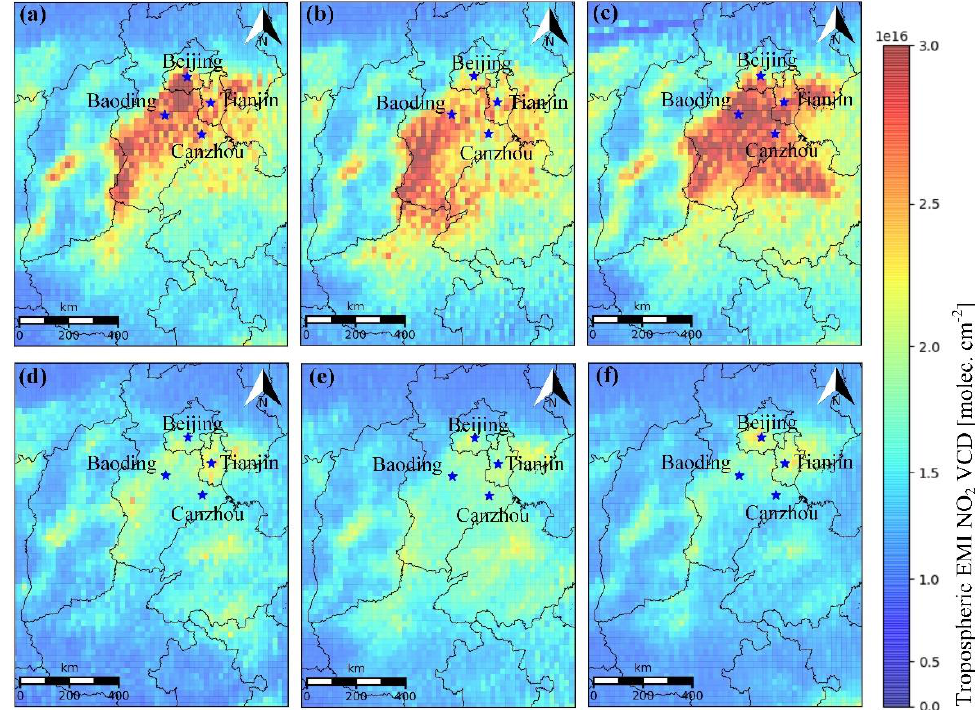
Figure 4. Monthly mean maps (0.18° × 0.18° grid) of EMI tropospheric NO 2 VCDs in ( a ) November 2018, ( b ) December 2018, ( c ) January 2019, ( d ) February 2019, ( e ) March 2019, and ( f) April 2019.